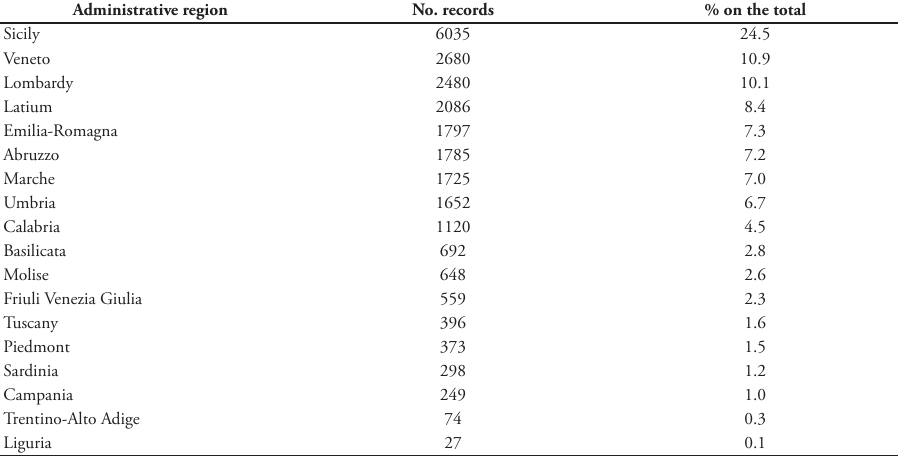
Table 4. Number and percentage of records per administrative region in the “Segetal flora of Italy” dataset. Administrative region No.